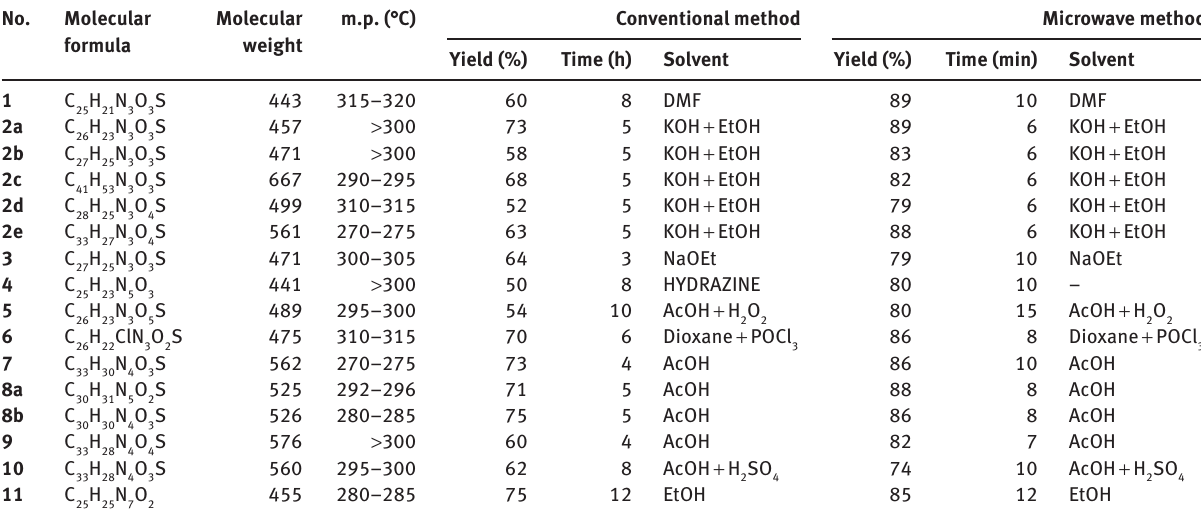
Table 2: The physical constants of the pyridopyrimidine derivatives 1–11. No. Molecular